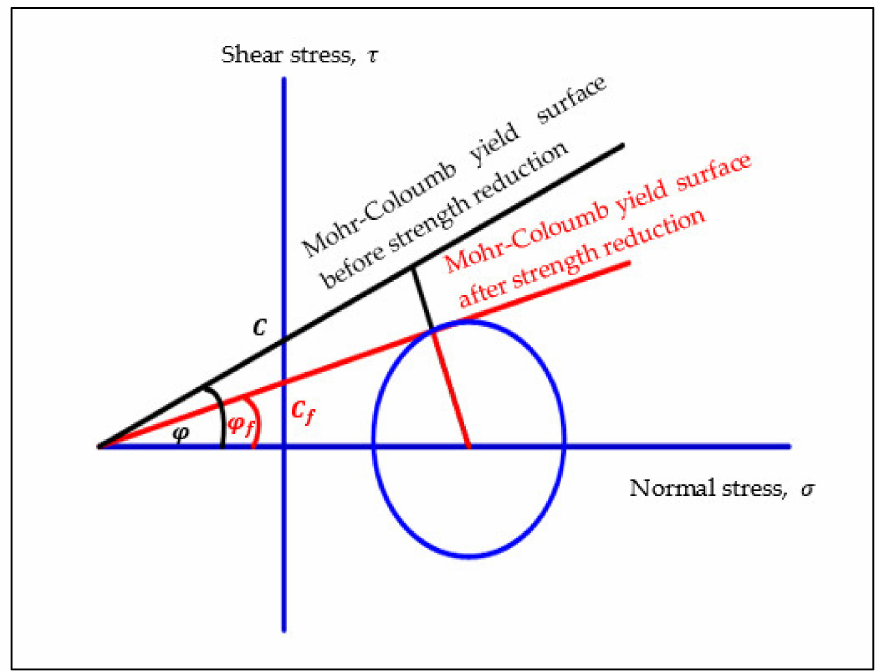
Figure 1. Mohr–Coulomb yield surfaces before/after strength reduction [17].